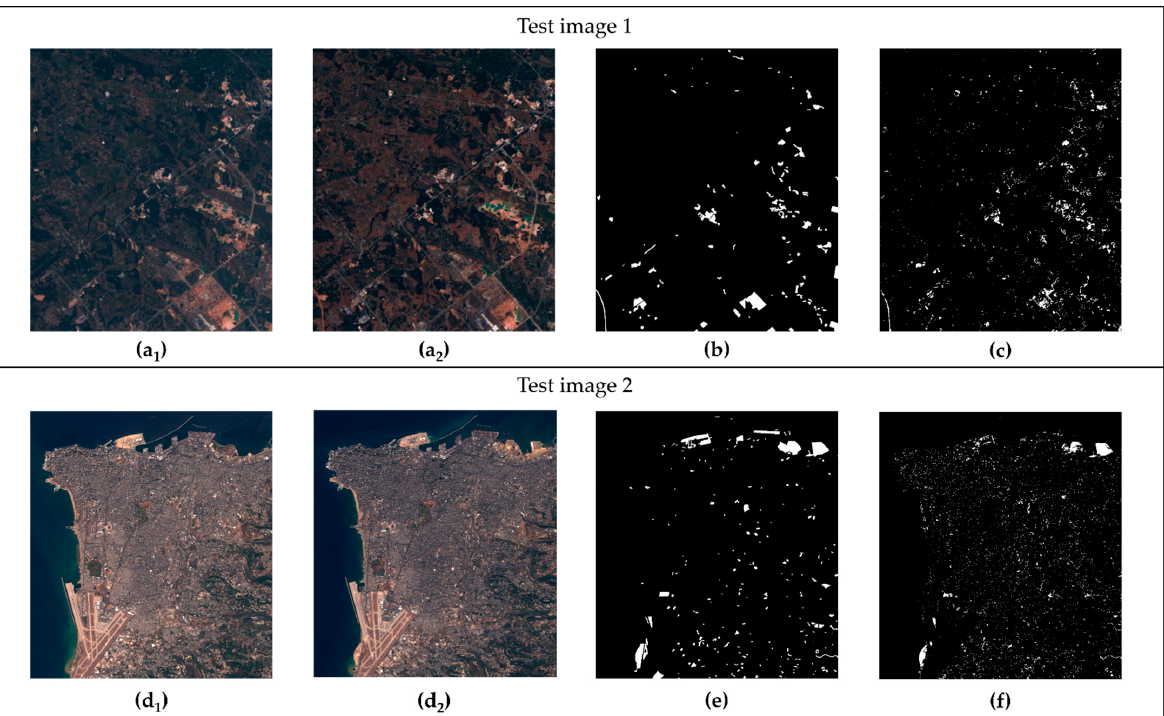
Figure 11. Examples 1 and 2 from test dataset: ( a 1 , d 1 ) images acquired at the time t 1 in RGB compo- sition; ( a 2 , d 2 ) images acquired at the time t 2 in RGB composition; ( b , e ) OSCD ground truth; ( c , f ) CVA ground truth (changed areas are shown in white).